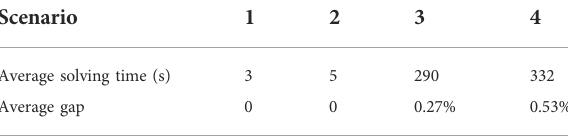
TABLE 1 Comparison of the average solving time and gap for the four scenarios. Scenario